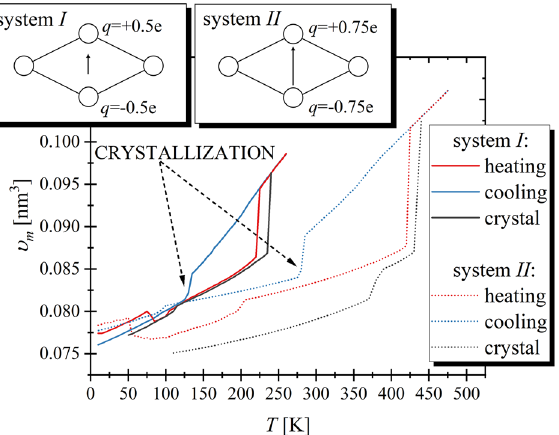
Figure 1. The temperature dependences of the volume for two studied model systems registered during heating and cooling are shown. The black lines represent the heating of the determined crystal structure. In the insets, the schemes of the structures of RM are